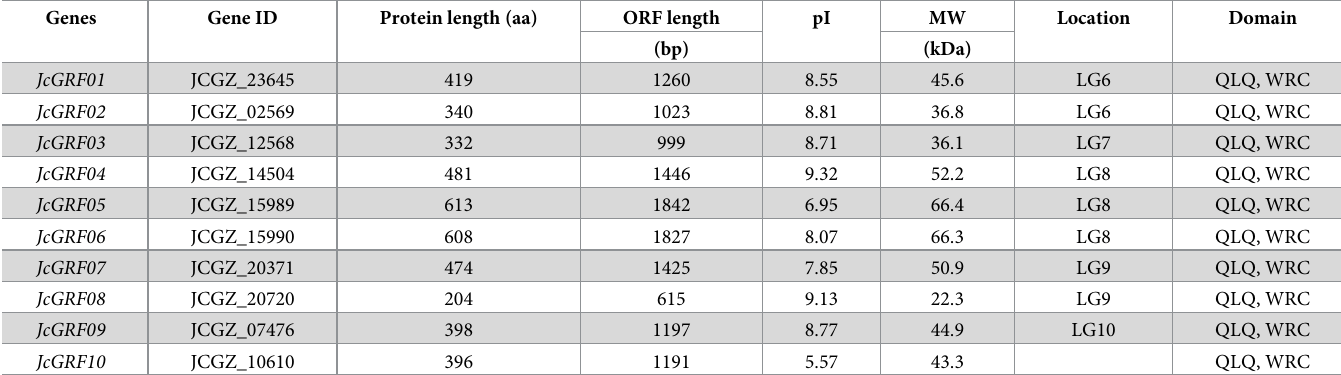
Table 1. Summary of JcGRF genes encoding GRF proteins in Jatropha curcas .